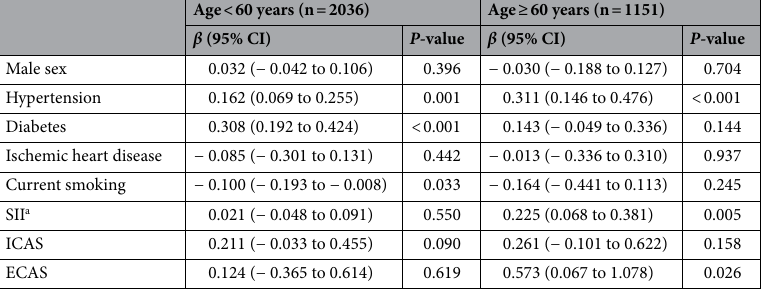
Table 2. Multivariable linear regression analysis of possible predictors for white matter hyperintensity volume (these variables were transformed into square root scales) according to the age. SII systemic immune- inflammation index, ICAS intracranial atherosclerosis, ECAS extracranial atherosclerosis. a These variables were transformed into log scales.